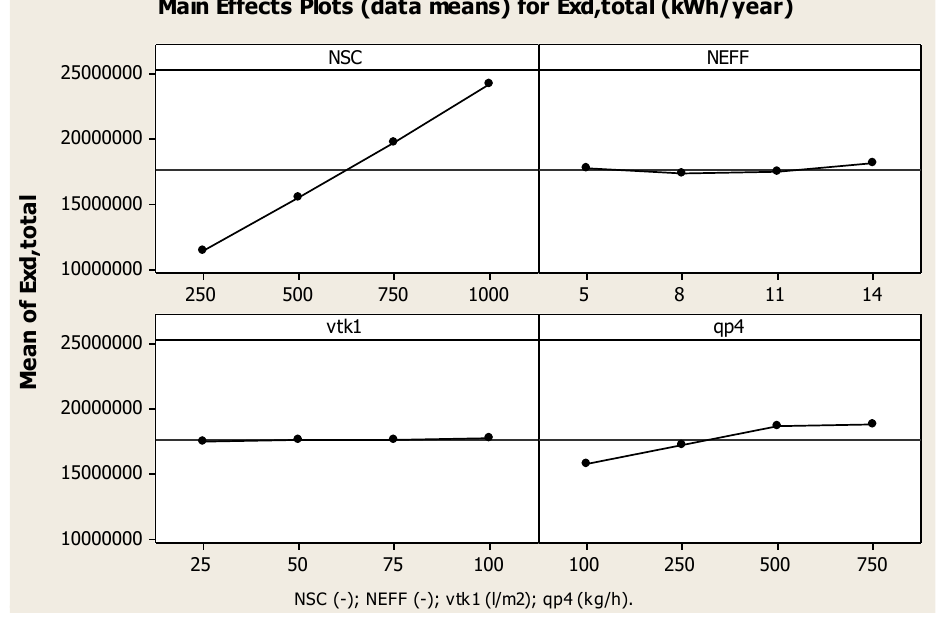
Figure 7. Main effects plots for Ex d,total .